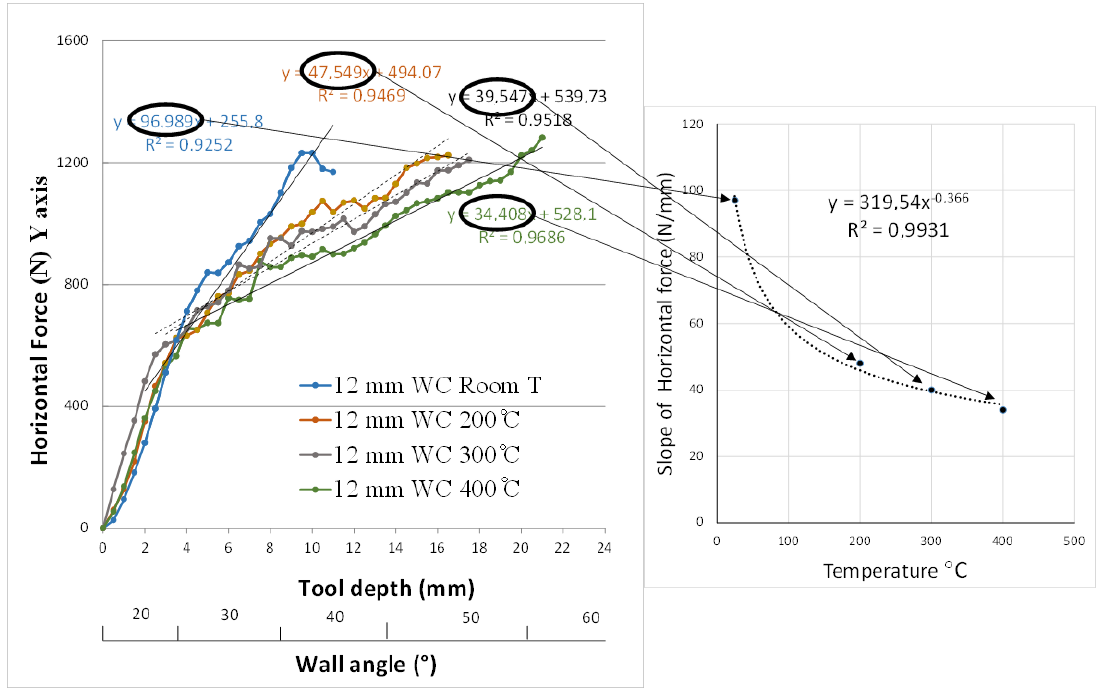
Figure 16. Relation between radial forces and test